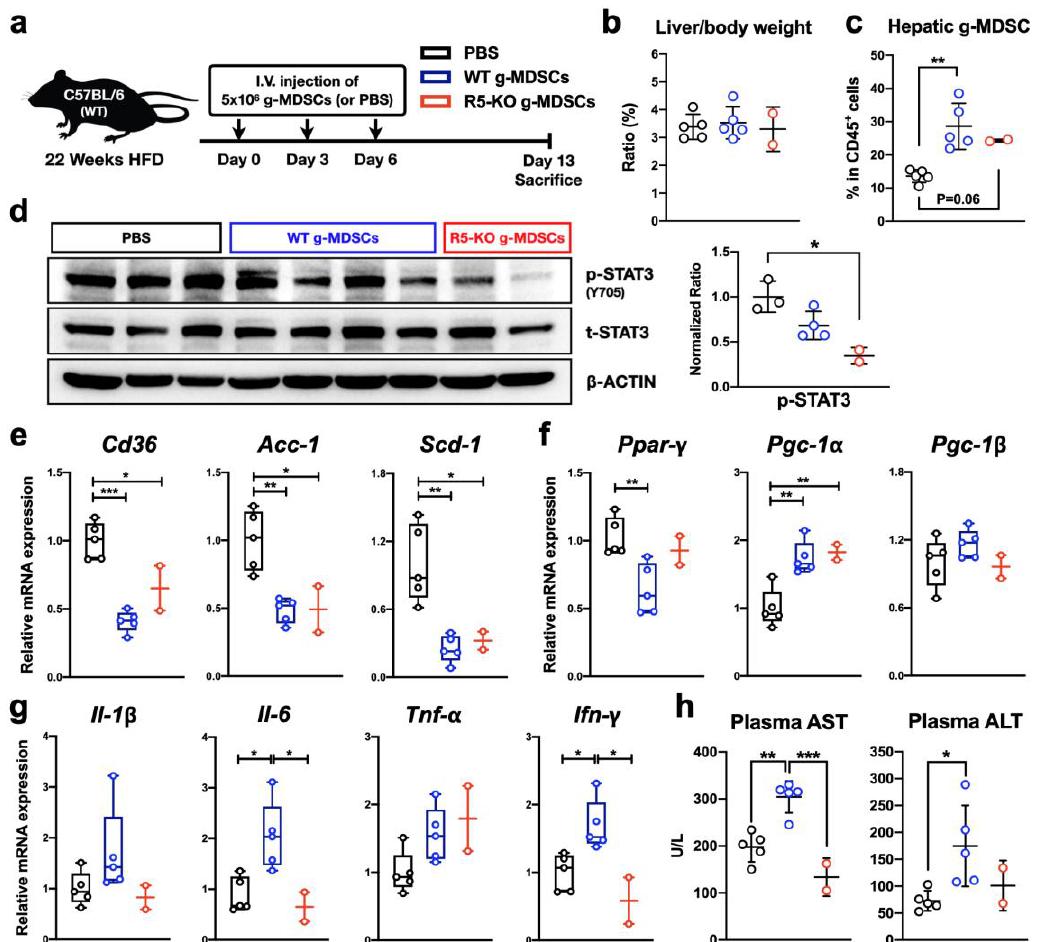
Figure 7. CCR5-deficient g-MDSCs reduce hepatic STAT3 activation and lipogenic gene expression in NAFLD. ( a ) A schematic diagram of the animal model for g-MDSC adoptive transfer. Obese WT mice were retro-orbitally injected with PBS, WT g-MDSCs, or R5-KO g-MDSCs three times before being sacrificed by 24 weeks of HFD. ( b ) The liver-to-body weight ratio was measured and calculated. ( c ) The amount of hepatic g-MDSCs was quantitated by flow cytometry and shown as percentages in the hematopoietic population as described for Figure 2. ( d ) The status of STAT3 phosphorylation was determined by immunoblotting of liver homogenates. The signal of phosphorylated STAT3 was normalized to total STAT3 and set the average value of the PBS-injected group to 1. Hepatic transcript levels of genes related to lipogenesis ( e ), Ppar- γ with its co-activators ( f ), and pro-inflammatory cytokines ( g ) were determined by real-time PCR. Expression was normalized to the 36b4 reference gene and further normalized to the average value of the PBS-injected group. ( h ) Plasma concentrations of AST and ALT were analyzed (n = 2-5). *, p < 0.05; **, p < 0.005; ***, p < 0.001.